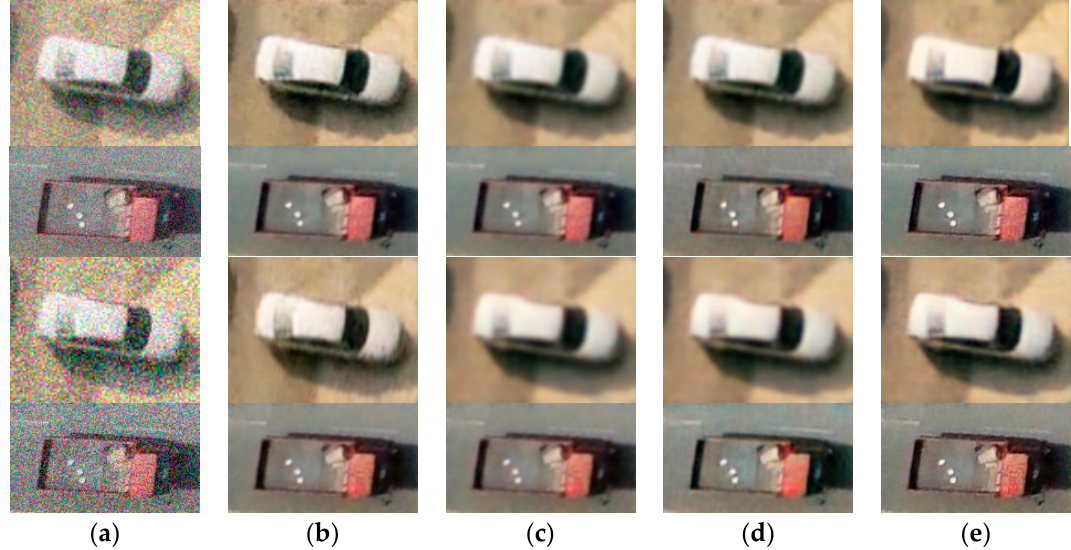
Figure 6. ( a ) Represent the noisy images of cars and trucks with different noise levels; ( b ) Represent the denoising results of method [8]; ( c ) Represent the denoising results of method [5]; ( d ) Represent the denoising results of method [17]; ( e ) Represent the denoising results of proposed method. Table 4. The comparison of the correct rate of denoised images classification.